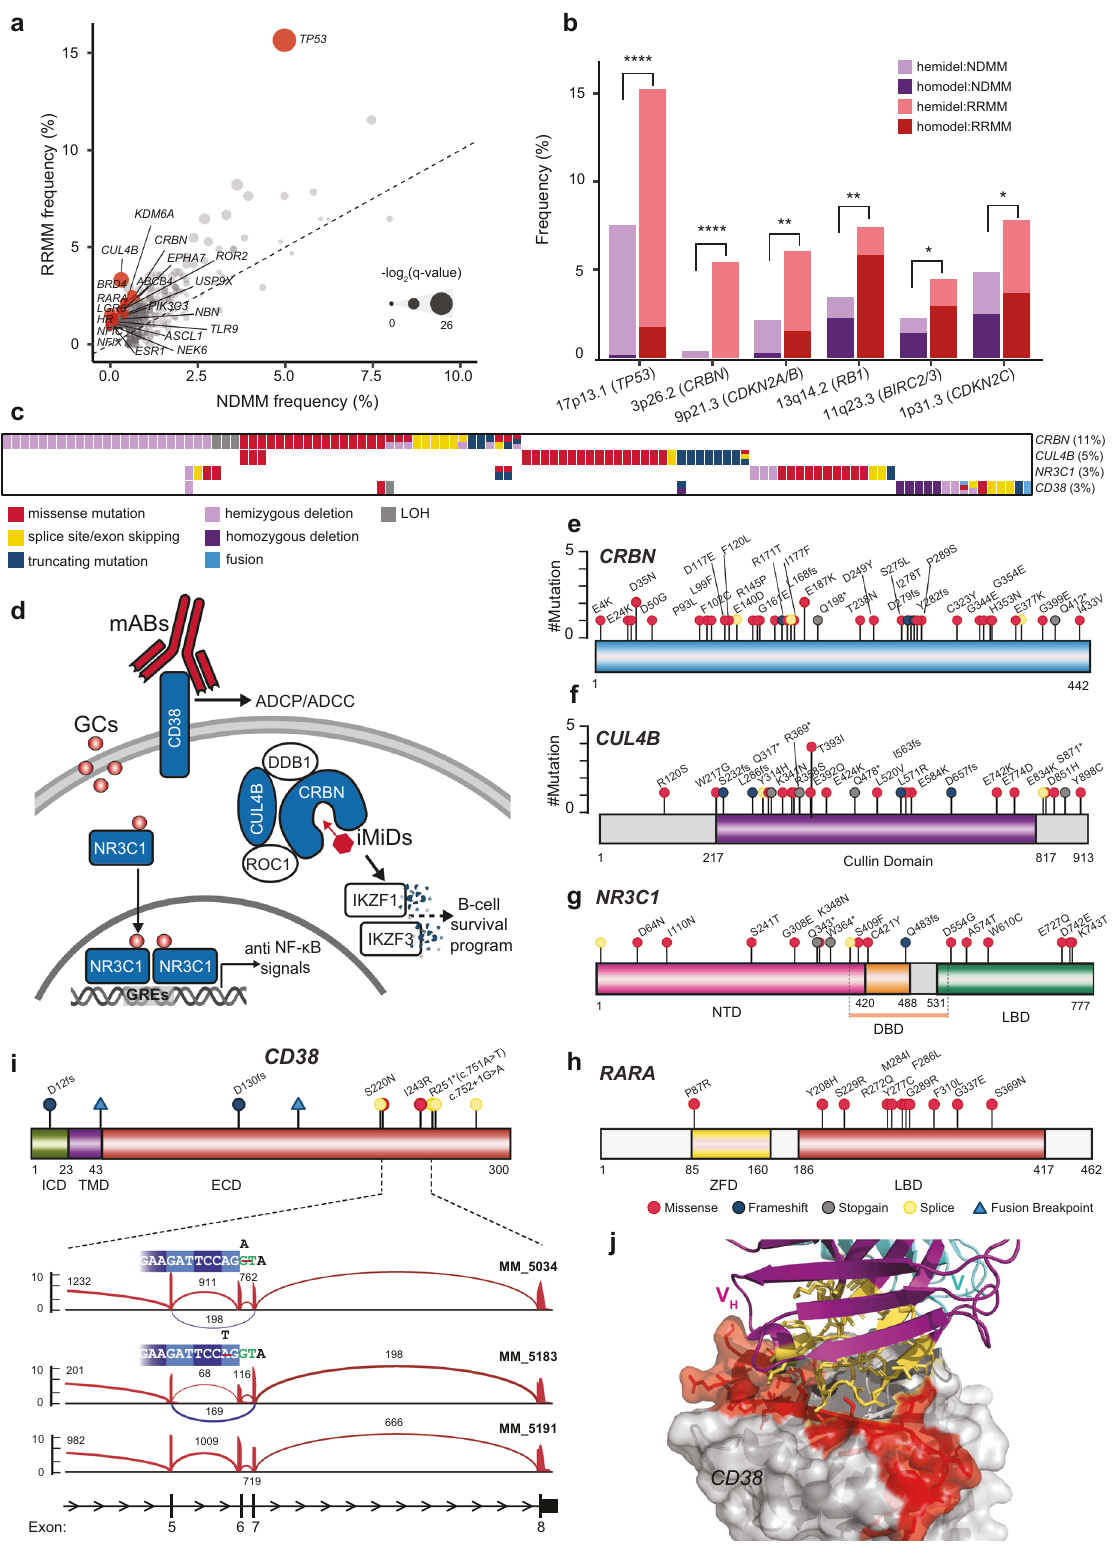
unexpectedly induced in-frame exon skipping and removed most of the epitopes on CD38 that interact with daratumumab 52 . These events may facilitate the evasion of MM cells from binding by daratumumab, while still retaining a major portion of the extracellular domain (Fig. 4i, j). Overall, CD38 mutations were associated with lower CD38 expression than the rest of the cohort